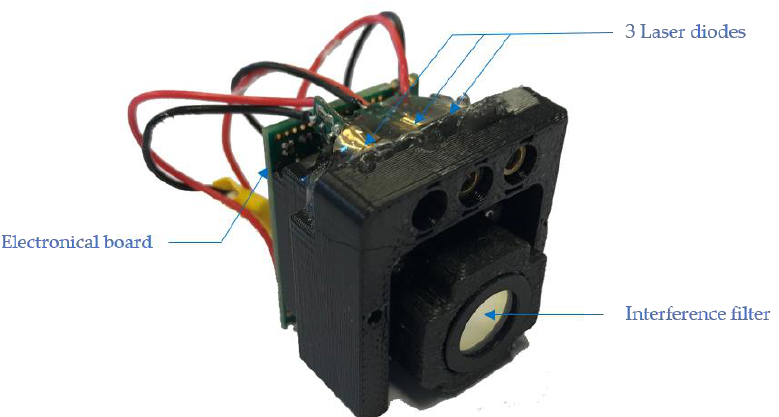
6 of 20 Figure 2. Basic scheme of the setup with three laser beams .